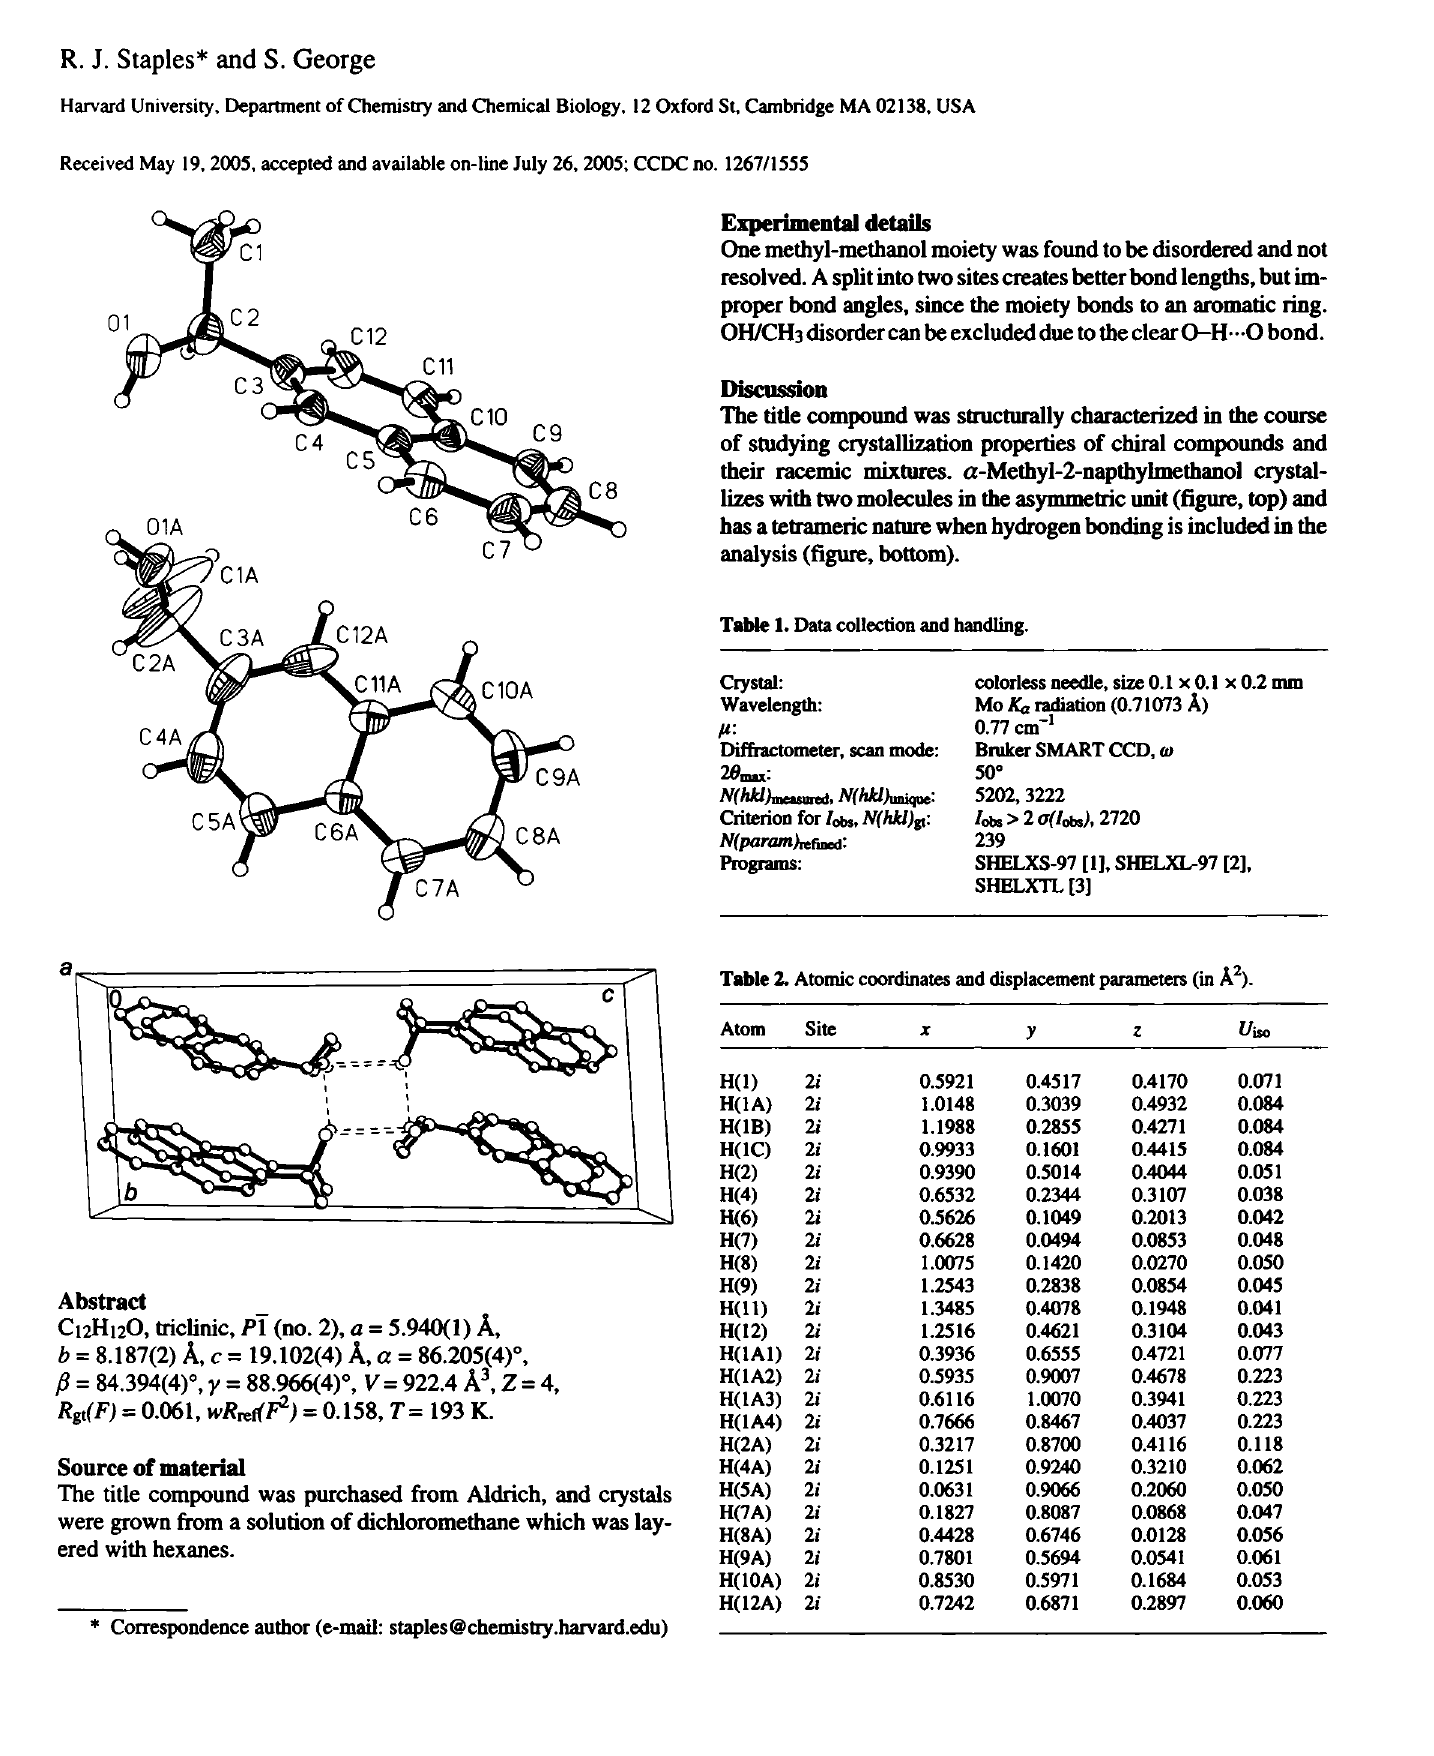
Table 1. Data collection and handling.